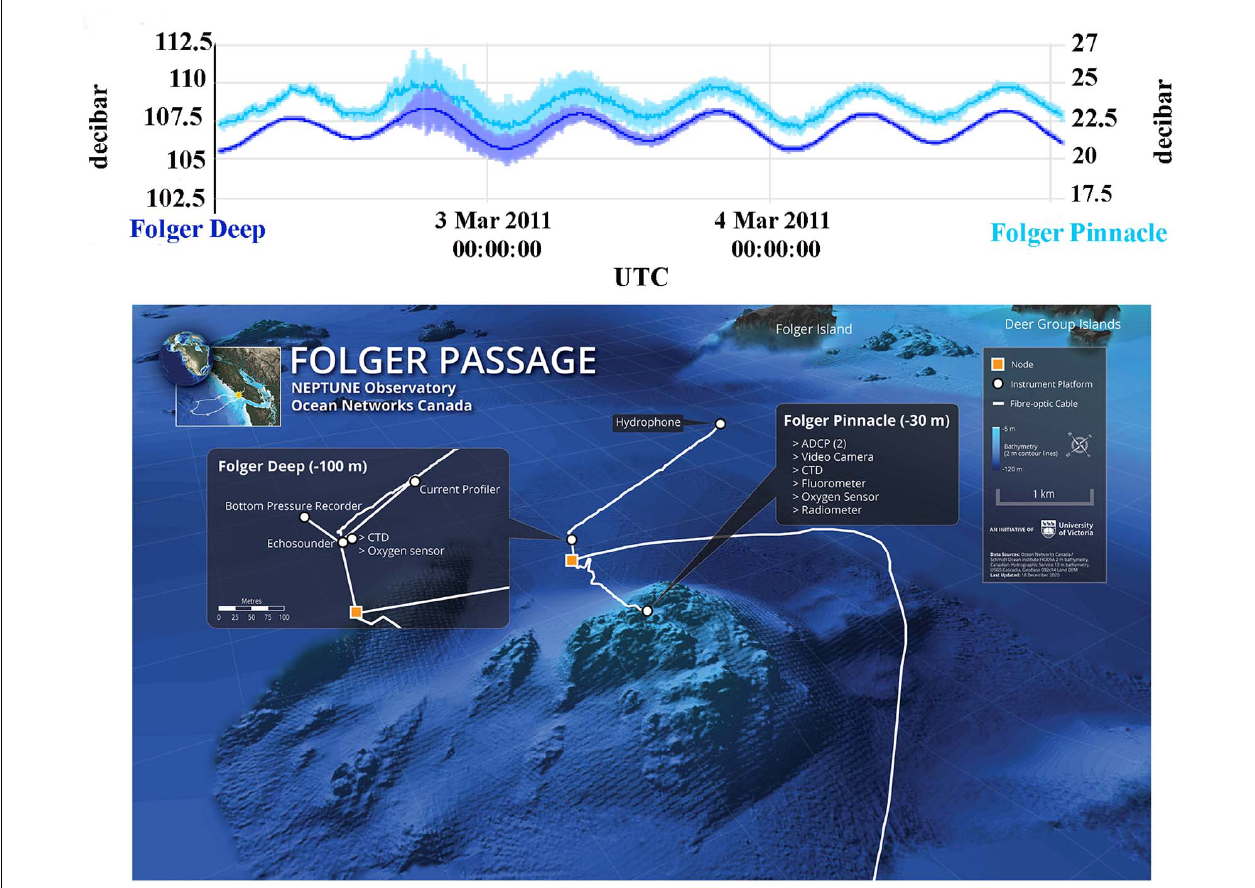
FIGURE 5 | A storm recorded by bottom pressure sensors, March 2–5, 2011, at Folger Deep (100 m, dark blue) and Pinnacle (25 m, light blue) sites, NEPTUNE Observatory, Ocean Networks Canada, NE Pacific (see Folger Passage map). Data shows both tidal (low frequency) and storm (moderate to high frequency) pressure changes. Plot and map from Ocean Networks Canada Data Archive